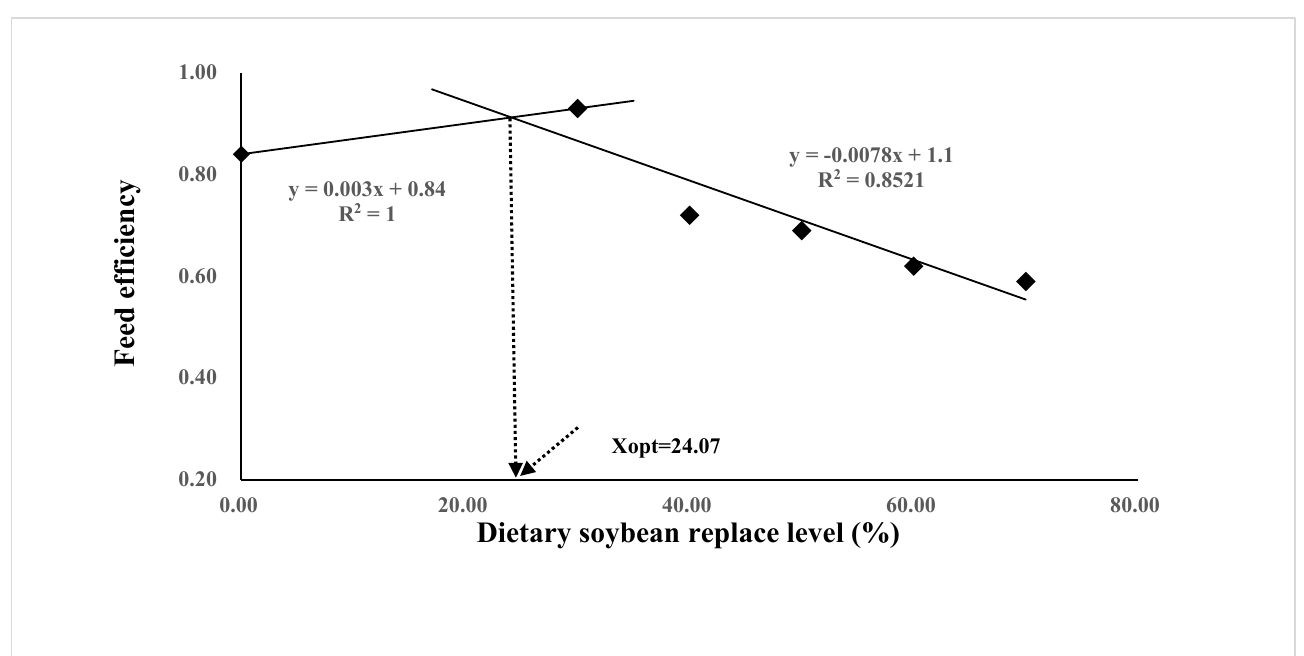
Figure 2. Relationship between the feed efficiency (FE) and the dietary soybean level based on two slope broken-line regression analysis, where Xopt represents the optimal dietary soybean replacement level for the maximum FE. Table 4. Growth, feed utilization, and morphometrical parameters of juvenile Oplegnathus punctatus fed diets containing different levels of soybean meal.